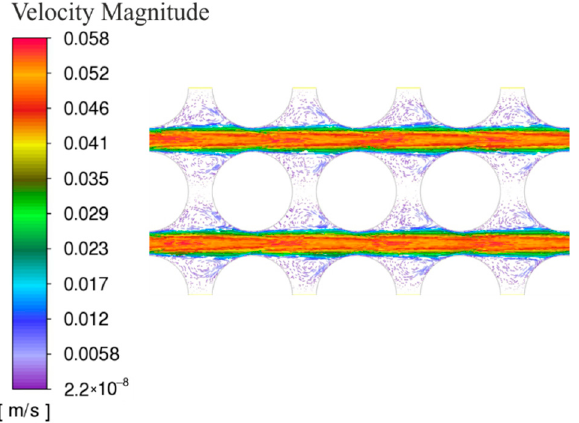
Figure 17. The velocity vector plots for the three central rows of the tube bundle at a steady flow.